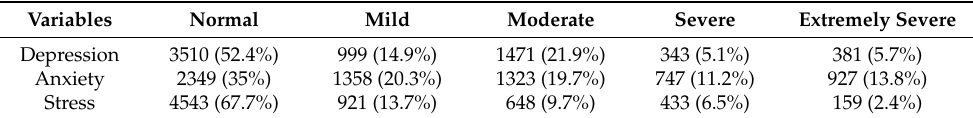
Table 3. Severity Distribution of Depression, Anxiety, and Stress in this